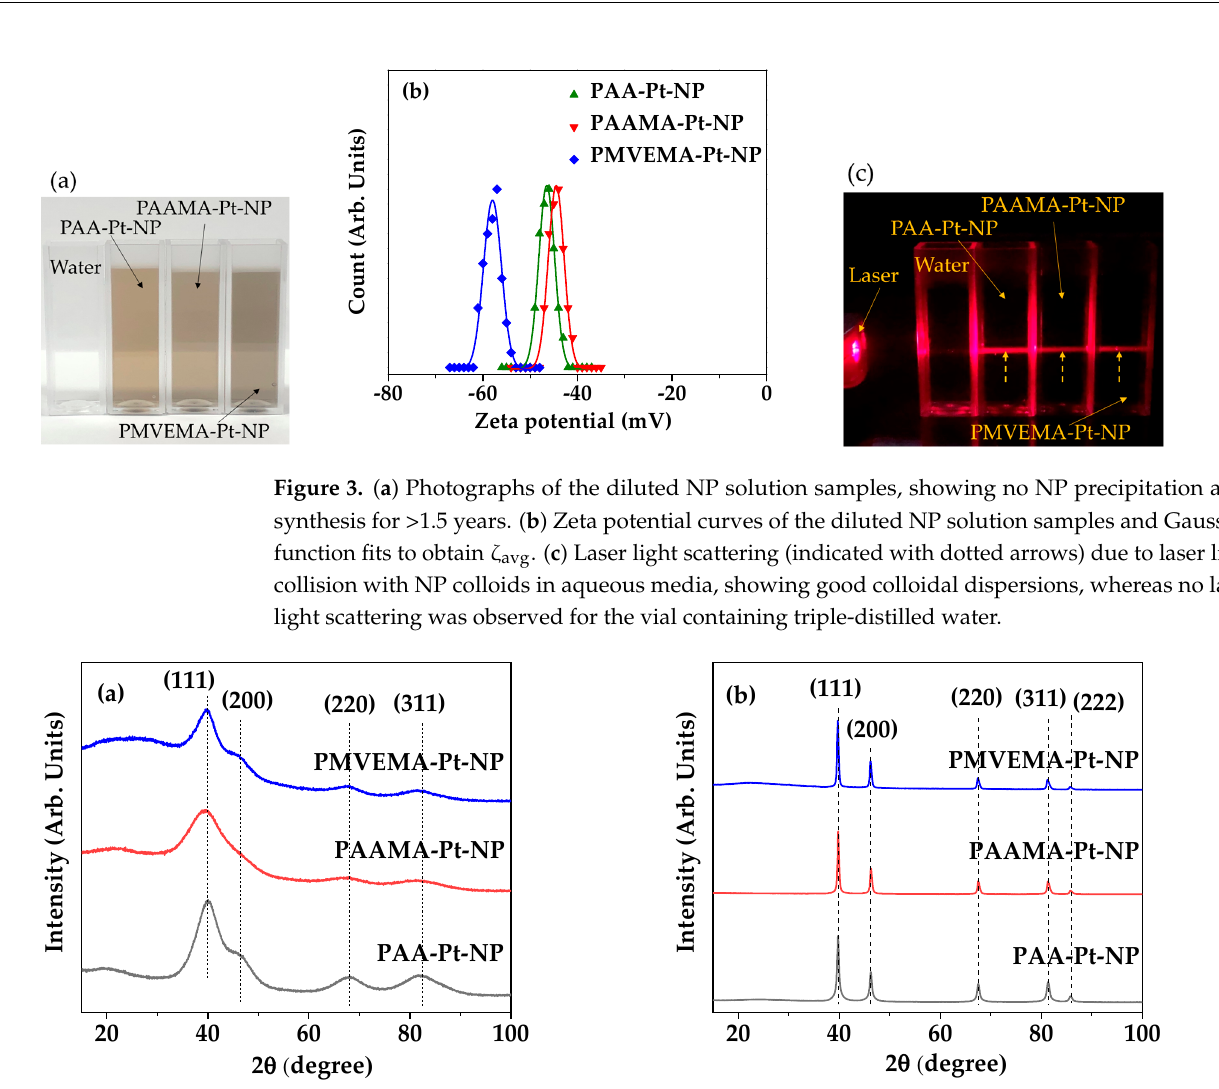
Figure 4. XRD patterns of the powder samples of PAA-, PAAMA-, and PMVEMA-coated Pt-NPs Figure 4. XRD pa tt erns of the powder samples of PAA-, PAAMA-, and PMVEMA-coated Pt-NPs ( a ) ( a ) before and ( b ) after TGA, up to 700 ◦ C under nitrogen flow. All peaks could be assigned with ( hkl ) before and ( b ) after TGA, up to 700 °C under nitrogen fl ow. All peaks could be assigned with ( hkl ) Miller indices of the fcc structure of bulk Pt metal. Miller indices of the fcc structure of bulk Pt metal.